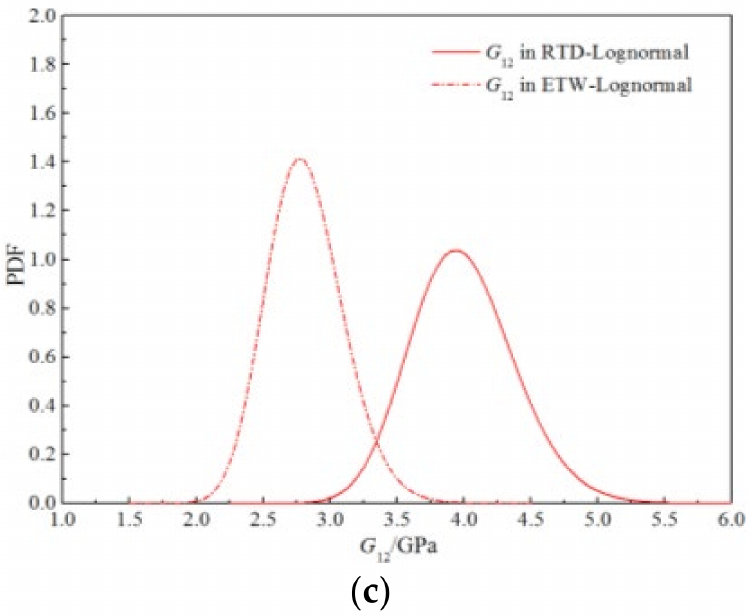
Figure 24. Comparison of the probability distribution curves for stiffness properties of H-GFRPs under different conditions. ( a ) E 11 , ( b ) E 22, ( c ) G 12